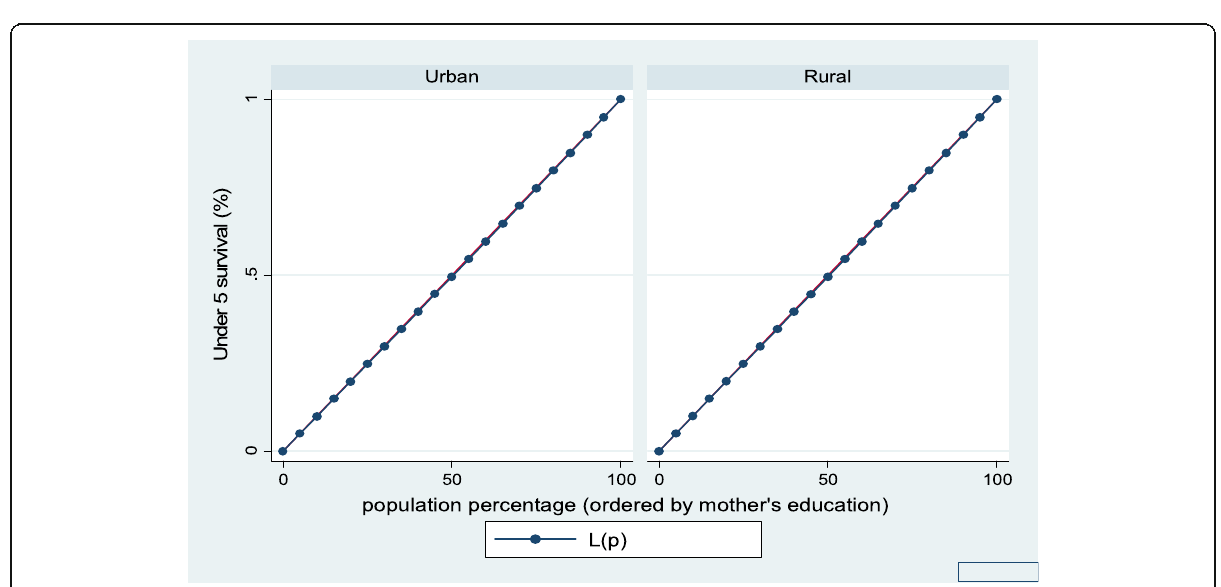
Fig. 12 Urban-rural Lorenz curve for childhood